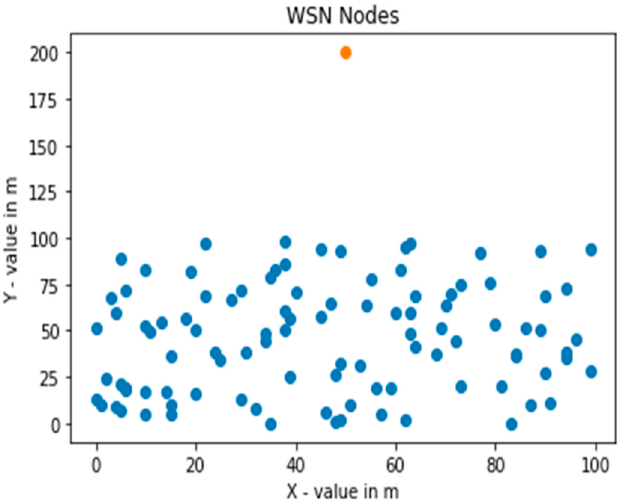
Figure 13. Random deployment of 100 sensor nodes in an area of 100 m × 100 m with BS positioned outside the deployment area at position (50, 200).